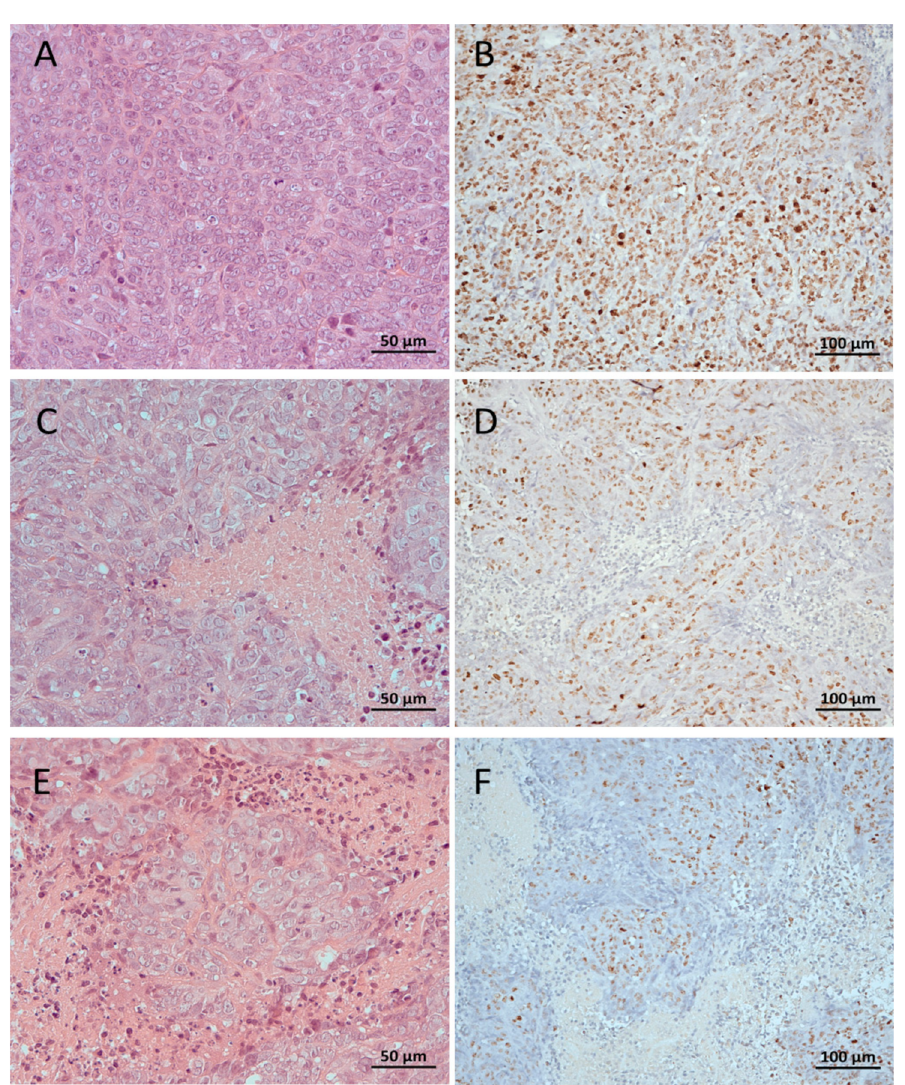
Figure 8. Subcutaneous xenografts induced by human colorectal carcinoma cells formed in athymic mice without PFK15 administration ( A , B ), with PFK15 applied in the morning ( C , D ), and with PFK15 applied in the evening ( E , F ). Hematoxylin and eosin, 400 × (left), and immunohistochemical staining with monoclonal antibody Ki-67, Polymer-Px (EnVision), and hematoxylin, 200 × (right). A , B : with strongly intense immunostaining in >80% of the cells; these cases contained regressive changes (necrosis) of the tumor parenchyma in the range of 11–25% of the area. C , D : the staining intensity: 2, moderately, to 3, strongly; the quantity of cells stained: 2, 11–50%; an immunoreactive total score: 4–6, moderate; regressive changes (necrosis) of the tumor parenchyma in the range of 26–49% of the area. E , F : an immunoreactive total score: 6, moderate, to 9, strong; regressive changes (necrosis) of the tumor parenchyma in the range of ≥ 50% of the